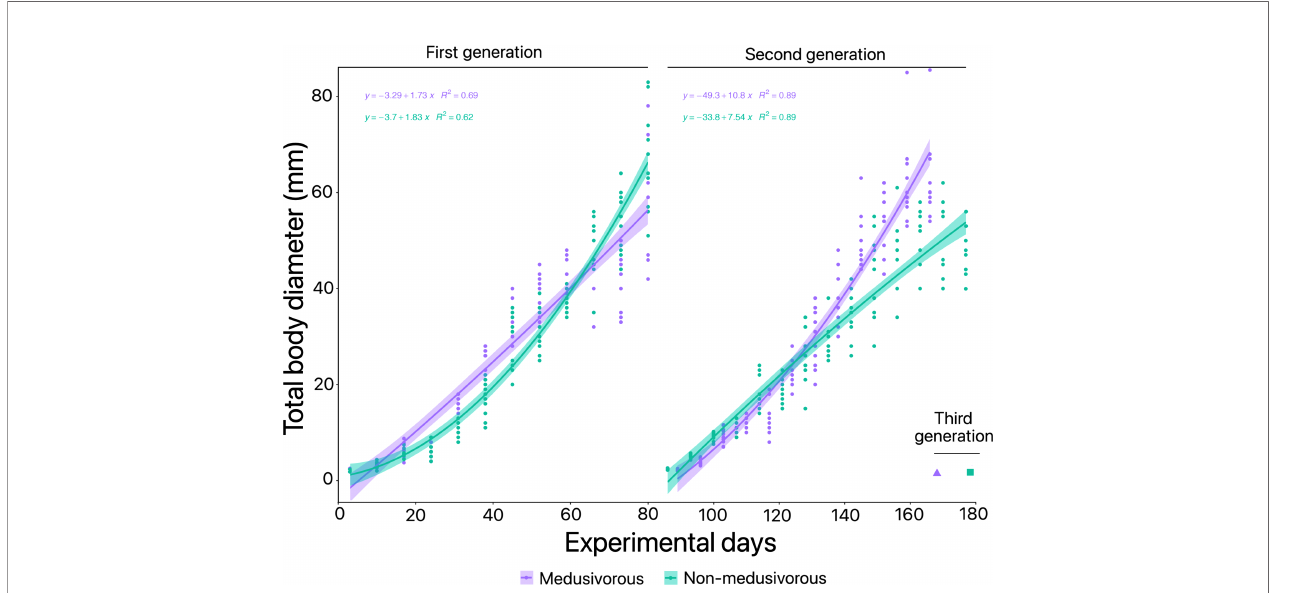
FIGURE 4 | Optimization of Pelagia noctiluca farming in the presence and absence of medusivorous prey. The three generations obtained from the beginning of the experiments are included. Culture 3, medusivorous diet (presence of Aurelia sp.) and Culture 4, non-medusivorous diet (absence of Aurelia sp.).